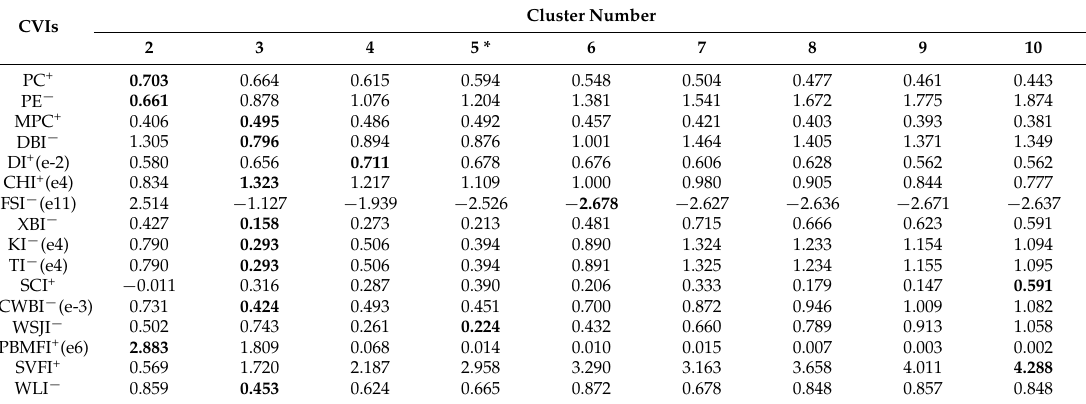
Table 10. Variations of the 16 CVIs with cluster numbers ranging from 2 to 10 for the ROSIS image.